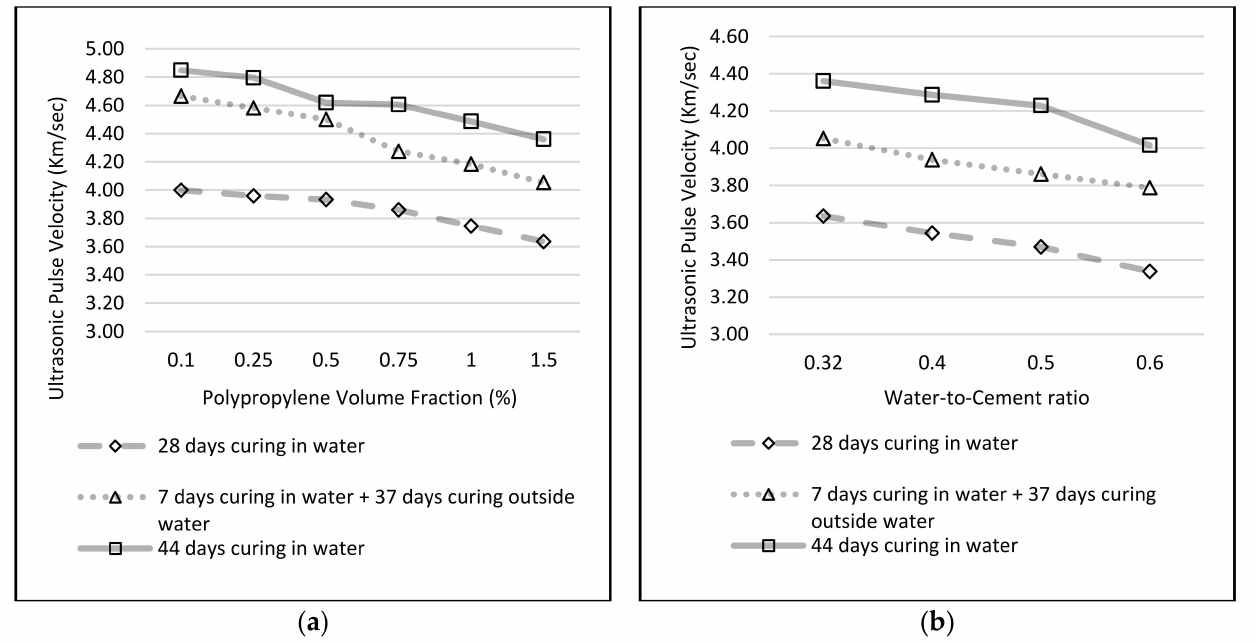
Figure 1. UPV vs. V f ( a ) and w/c ( b